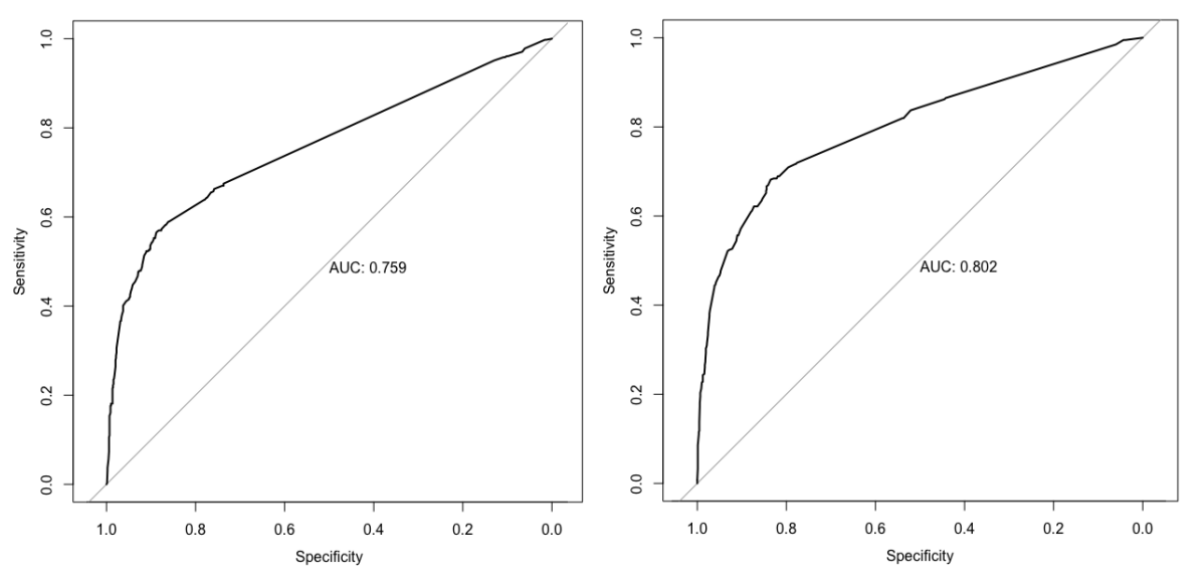
Figure 3. Receiver operating characteristic of the symptom-only model (left) and full model (symptom, sex, age >70 years, and household infected member model; right). AUC: area under the